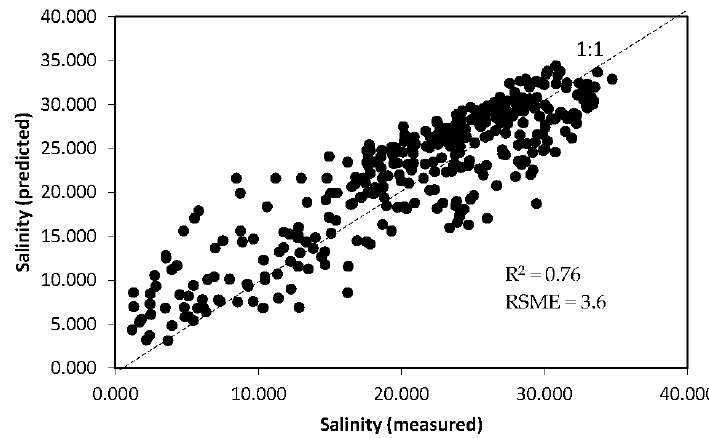
Figure 7. Scatterplot of measured salinities and salinities predicted based on the generalized salinity model for stations ( n = 331) in NB, NR, PB estuaries and inner shelf of Gulf of Mexico.